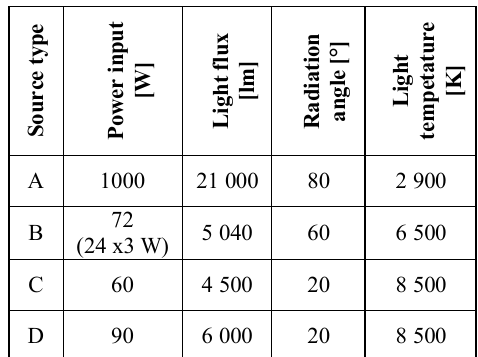
Table 1. Parameters of light sources tested.